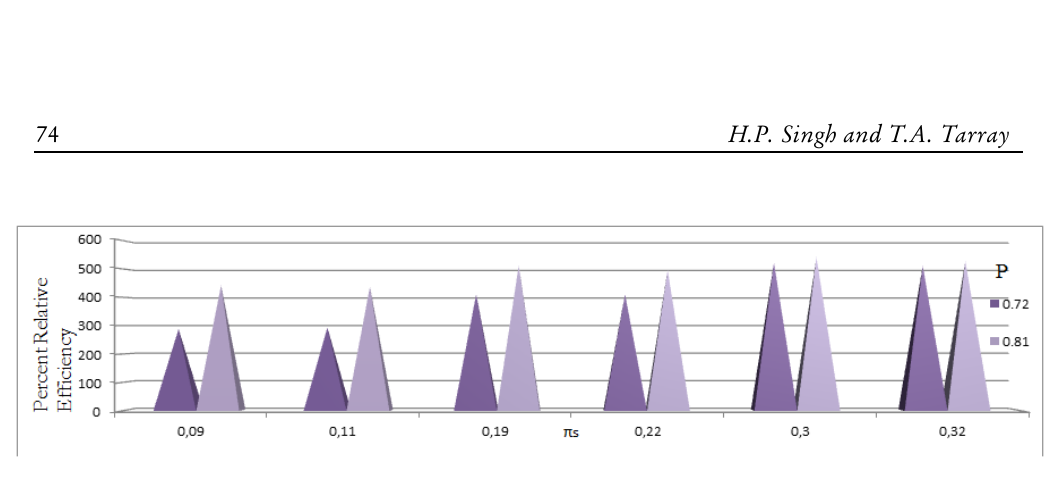
Figure 1 – Percent relative efficiency of the proposed estimator to Mangat and Singh (1994) estimator